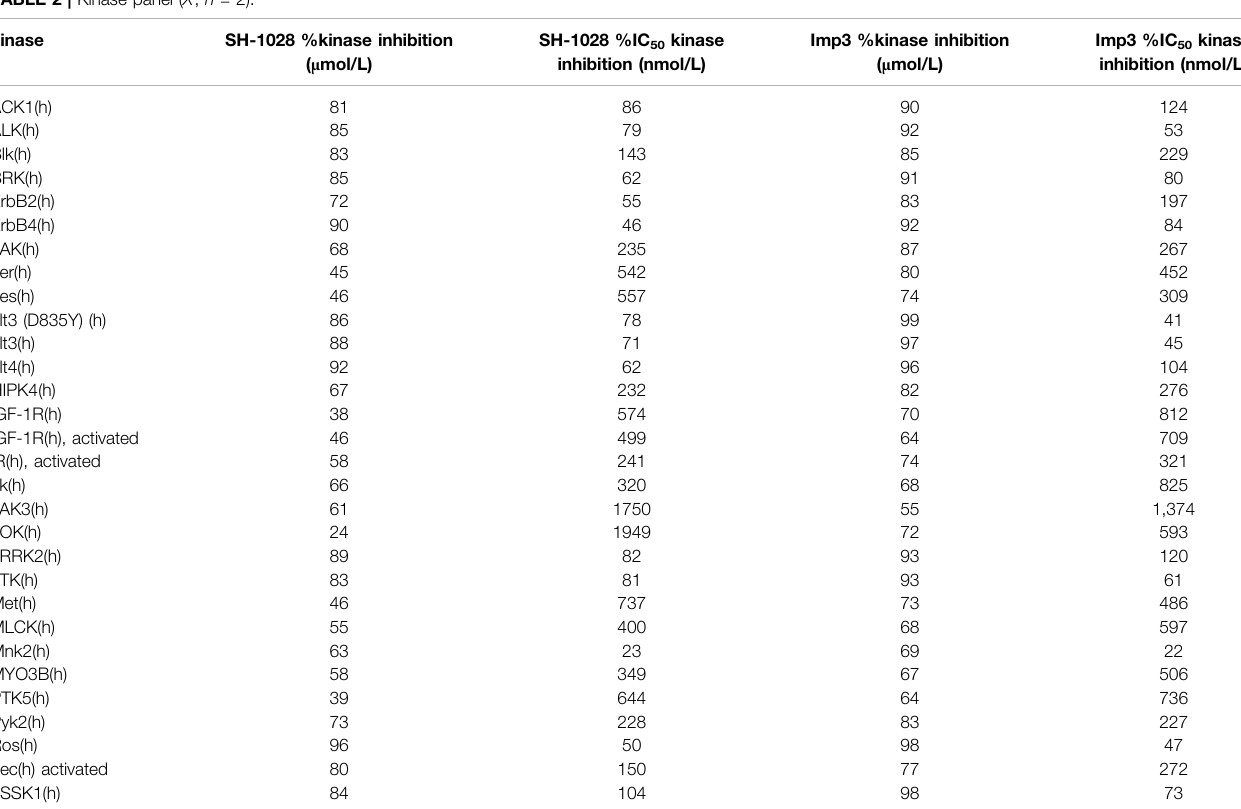
TABLE 2 | Kinase panel ( X ; n (cid:1) 2).